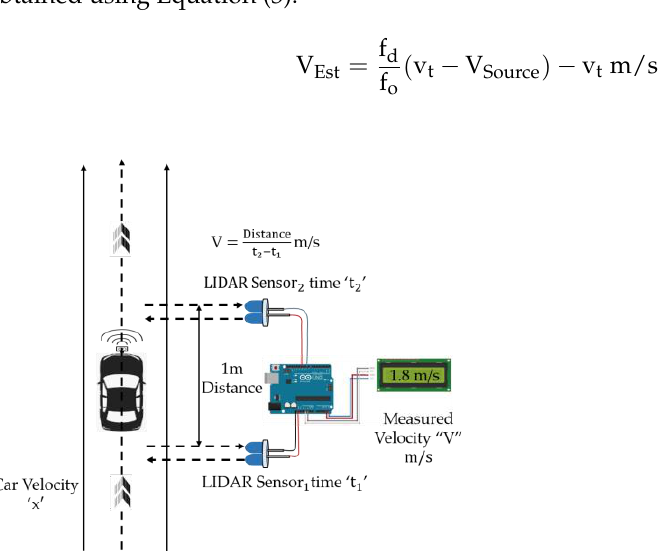
Figure 3. Measurement of car velocity using LIDAR sensors and microcontroller. Table 3. Comparisons of three velocities measured and estimated using the Doppler shift.